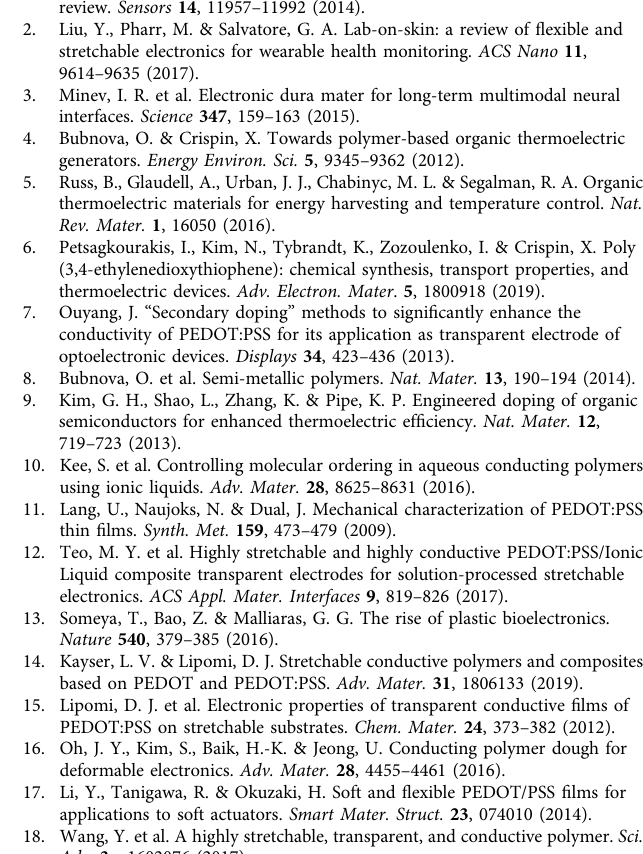
Fig. 16. The two edges of a stretchable TE module were fi xed on glass slides by Kapton tape with an initial distance of 25 mm. The module was stretched by placing another glass slides with different distances between two fi xing slides. The module was torn when strain increased over 50% due to the limited stretchability of PDMS at a low aspect ratio of 25:60 (length:width). A 5-leg TE module was fabricated via the same process but with an additional encapsulation layer of